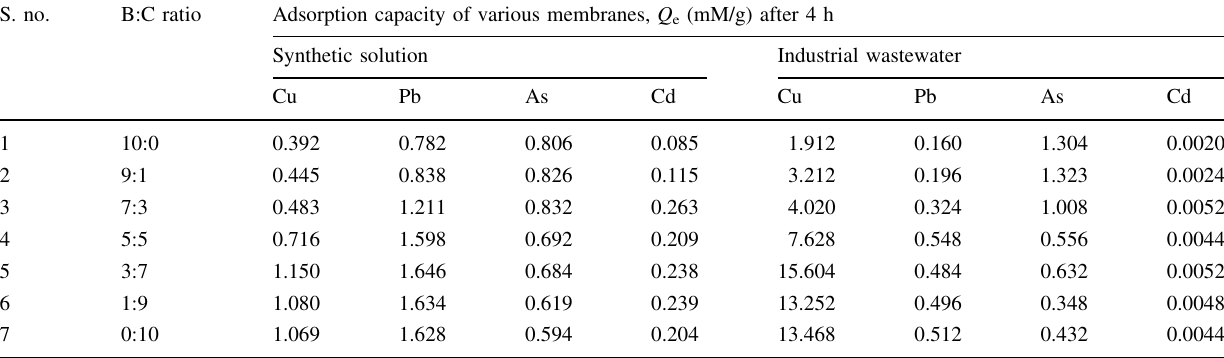
Fig. 3 Heavy metals adsorption capacity of B:C membranes in synthetic